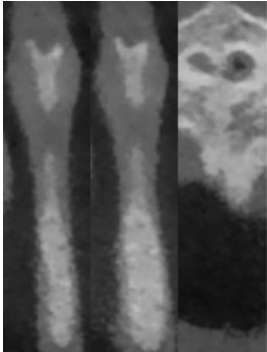
Figure 6. The image example of extracted region of interest (ROI) for midpalatal suture.